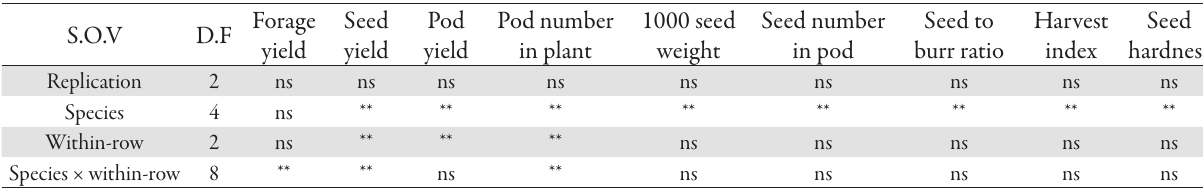
Tab. 2. Statistical probabilities of F test for main effects and their interactions on forage and seed yield, yield components, seed to burr ratio, harvest index and seed